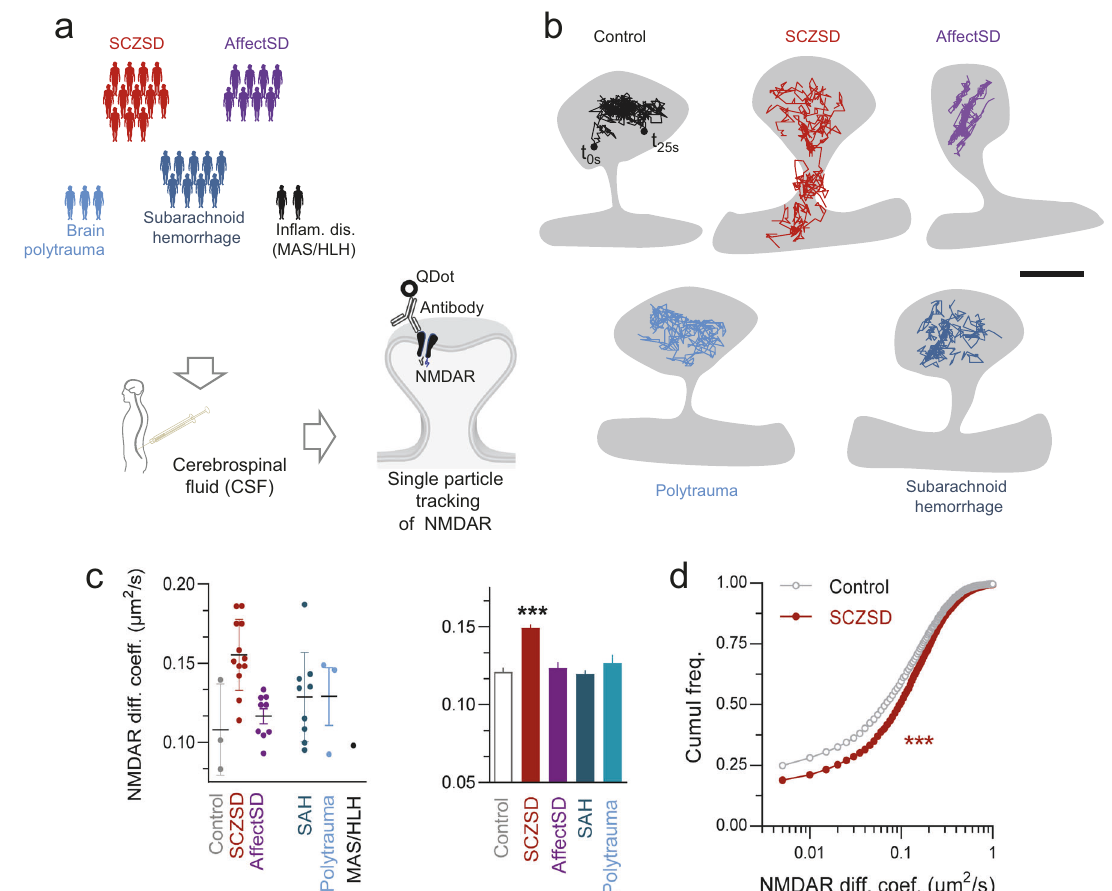
Fig. 1 Cerebrospinal fl uid (CSF) from patients with SCZSD alters the surface dynamics of synaptic NMDAR. a Schematic description of the experimental work fl ow. CSF from patients with schizophrenic spectrum disorders (SCZSD, n = 12), affective spectrum disorders (AffectSD, n = 9) subarachnoid hemorrhage (SAH, n = 9 patients), brain polytrauma ( n = 3), hemophagocytic lymphohistiocytosis (HLH, n = 1), were collected. Then, single nanoparticle (QDot) tracking of GluN2B-NMDAR was performed onto cultured hippocampal neurons exposed to CSF. b Representative trajectories (50 ms acquisition) of surface GluN2B-NMDAR-QD complexes in dendritic spines of neurons exposed to various CSFs. Scale bar = 300 nm. c Diffusion coef fi cient (µm 2 /s) of synaptic GluN2B-NMDAR values after exposure for 15 – 30 min to patients ’ CSF. Each plotted dot corresponds to the median diffusion coef fi cient value of one patient CSF. The mean and standard deviation (SD) are represented for each condition. Right panel , Comparison of GluN2B-NMDAR synaptic diffusion coef fi cient values after exposure for 15 – 30 min to patients ’ CSF (Control, n = 2757 trajectories; SCZSD, n = 5849; AffectSD, n = 2410; Polytrauma, n = 825; SAB, n = 3957; *** p < 0.0001, Kruskal – Wallis followed by Dunn ’ s multiple comparison test). Data are represented as mean ± sem. d Cumulative distributions of GluN2B-NMDAR instantaneous diffusion coef fi cient (µm 2 /s) in control condition and SCZSD CSF ( p < 0.0001, Kolmogorov – Smirnov of the NMDAR surface dynamics (two patients exhibited values RESULTS similar to those in control CSF). Thus, the CSF of patients suffering Cerebrospinal fl uid (CSF) from patients with SCZSD alter from SCZSD, but not of major neurological and in fl ammatory NMDAR surface dynamics and organization conditions, rapidly and potently displaced surface NMDAR. Such a In order to test the hypothesis that the CSF of patients suffering rapid change in surface dynamics would likely alter the synaptic from SCZSD can alter the organization and function of NMDAR NMDAR content. To address this possibility, we labeled surface located at the plasma membrane of neurons, we performed a NMDAR in live hippocampal neurons exposed to CSF from either single nanoparticle tracking experiment in cultured hippocampal psychiatric (i.e., SCZSD) or subarachnoid hemorrhage condition. As neurons. Cells were acutely exposed to CSF collected from previously shown [38, 40], most of the surface NMDAR clusters patients with various neurological, in fl ammatory, and psychiatric colocalise with postsynaptic markers, such as Homer 1c (Fig. 2b). conditions (Fig. 1a), and the membrane dynamics of synaptic In the presence of SCZSD CSF, the NMDAR cluster area was NMDAR were recorded (see “ Methods ” section). In control signi fi cantly reduced (Fig. 2c). The cumulative distributions of condition (untreated neurons), surface NMDAR diffuse along NMDAR cluster area indicate that the observed decrease with dendritic segments and were more con fi ned in synapses and SCZSD CSF is due to a left shift of the whole population (Fig. 2c). In spines (Fig. 1b), as previously reported [40, 41]. NMDAR surface order to test whether the CSF effect was speci fi c for NMDAR, we diffusion was not signi fi cantly affected in presence of any of the measured the membrane cluster area of glutamatergic AMPA, patients ’ CSF but the SCZSD CSF. Indeed, SCZSD CSF induced a dopaminergic D1, and GABAergic GABA A receptors. The mem- destabilization of synaptic NMDAR as witnessed by a 30% increase of NMDAR instantaneous diffusion coef fi cient (Fig. 1c) and a brane and synaptic clusters of AMPA and GABA A receptors reduced fraction of immobile NMDAR at the synapse (Fig. 1d). Out remained unaffected by the presence of SCZSD CSF (Fig. 2d, e; of the 12 patients with SCZSD, 10 exhibited this clear upregulation Supplementary Fig. 1). It can be noted that dopaminergic D1